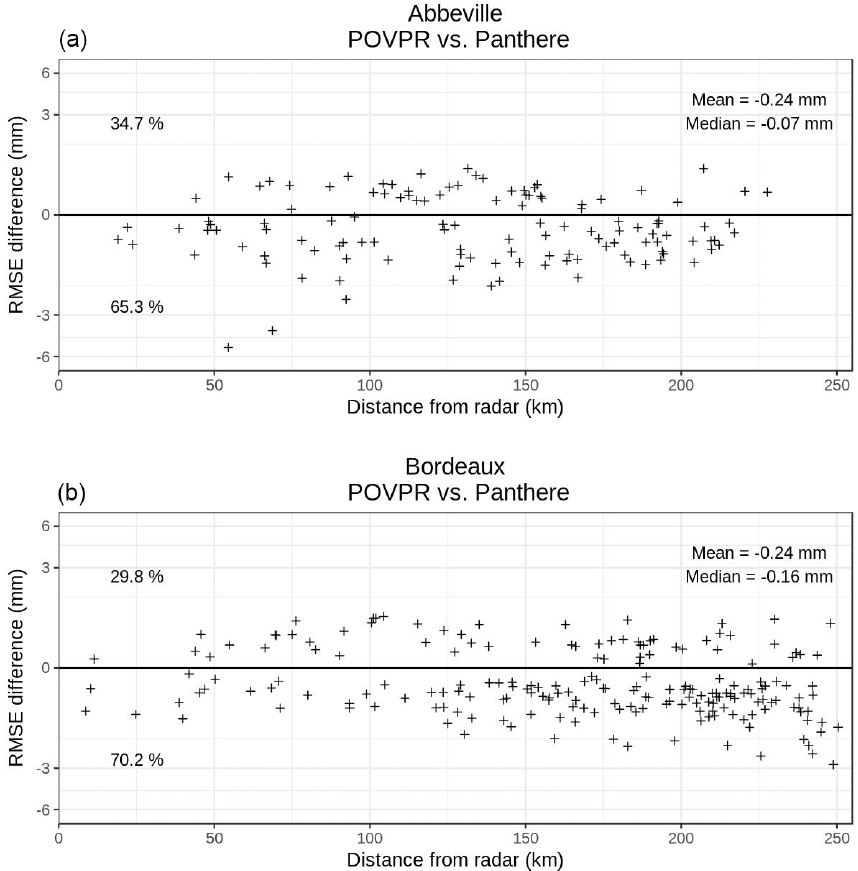
Figure 8. Differences between mean hourly RMSEs at the rain-gauge locations from the POVPR QPE and from the Panthere QPE according to the distance from the radar for the 30 April 2018 event between 03:00 and 09:00UTC on the Abbeville radar domain (a) and for the 3 March 2017 event between 18:00 and 00:00UTC on the Bordeaux radar domain (b) . Negative values indicate a better estimation of the POVPR QPE (lower RMSE) and positive values mean the opposite. The percentages of positive and negative values of RMSE difference are also